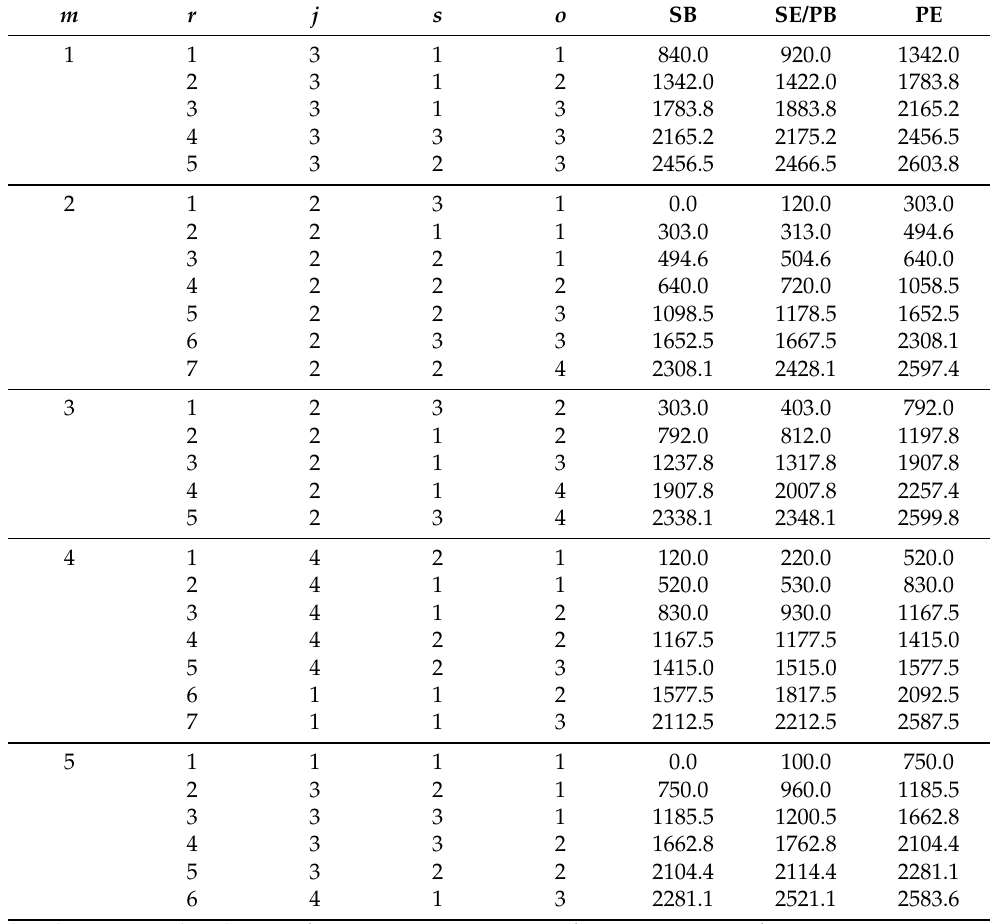
Table 7. Operation scheduling for Problem-1 with reference to the machines.